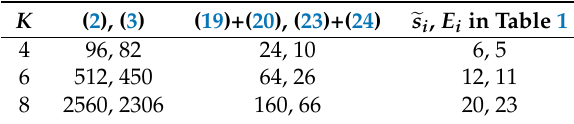
Table 3. Complexity of estimating (cid:101) s i and E i in terms of the number of multiplications.